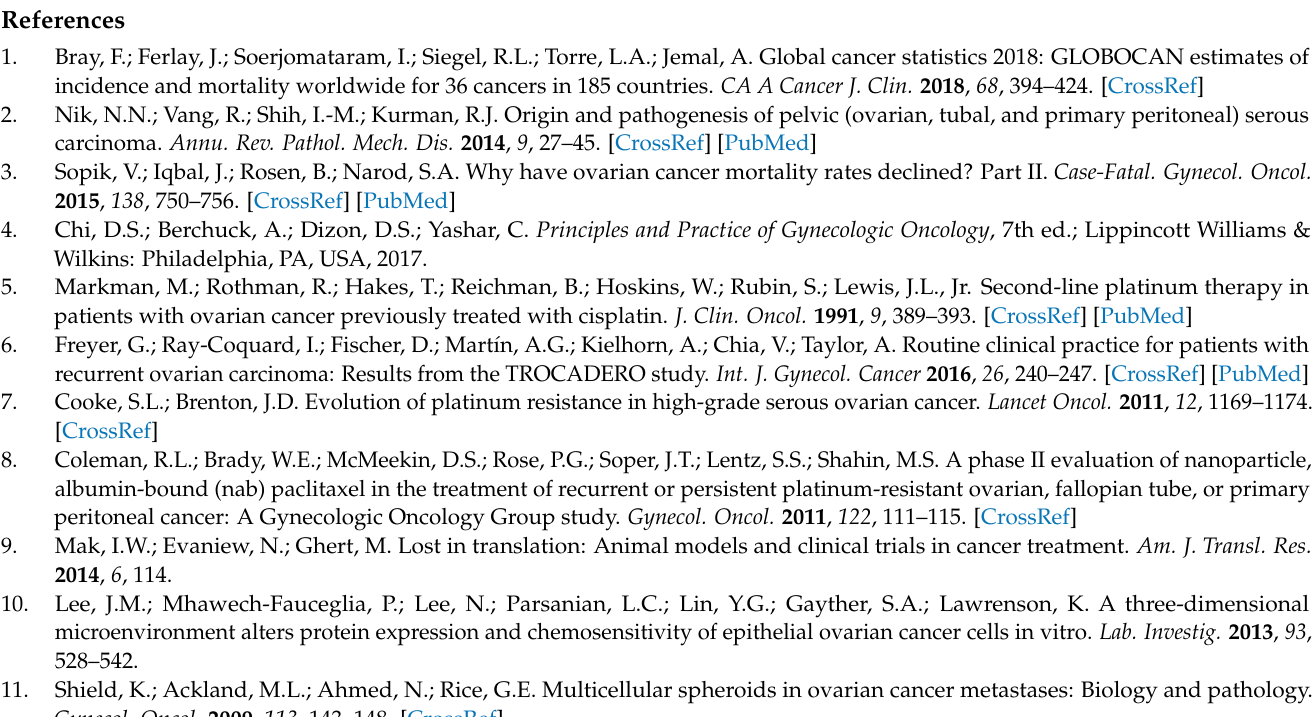
Figure A1. Direct visualization of 3D growth of Ovcar-3 cells under various treatments over time. In 3D culture, paclitaxel spheroids continue to grow to at the same rate of the control, while panobinostat is superior in effecting spheroid shrinkage. Spheroids exposed to cisplatin and cisplatin–paclitaxel grow at a rate similar to the control. Scale bar is 500 µm.